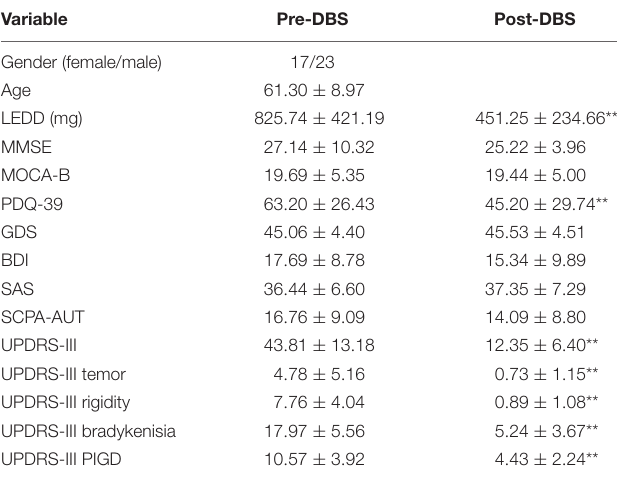
TABLE 1 | Baseline and postoperative demographic clinical